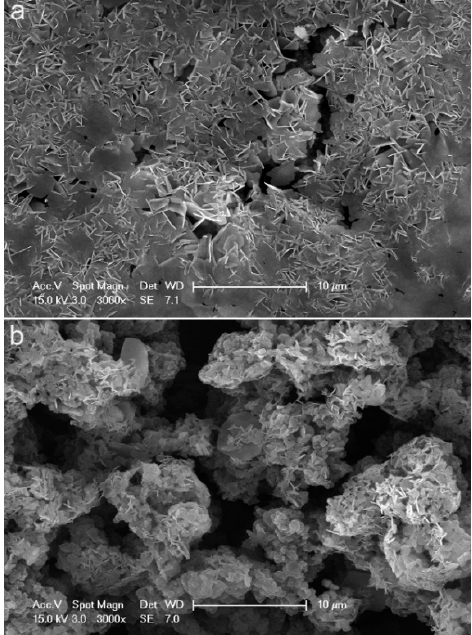
Figure 2. SEM images of the coatings of PANI nanotubes ( a ), and aggregated PANI ( b